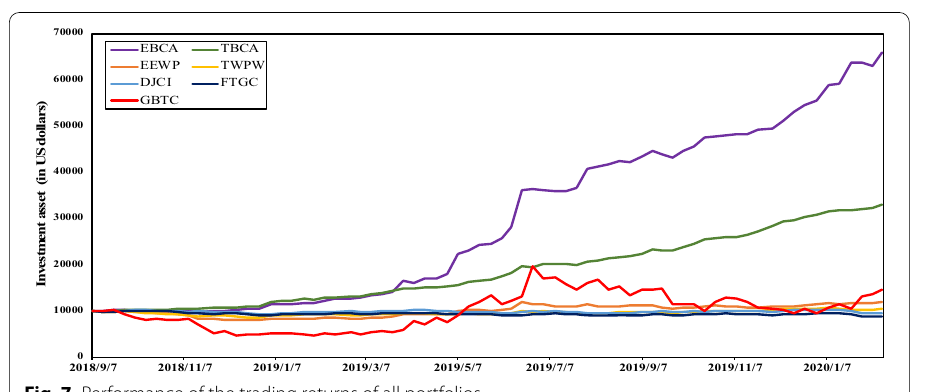
Fig. 7 Performance of the trading returns of all